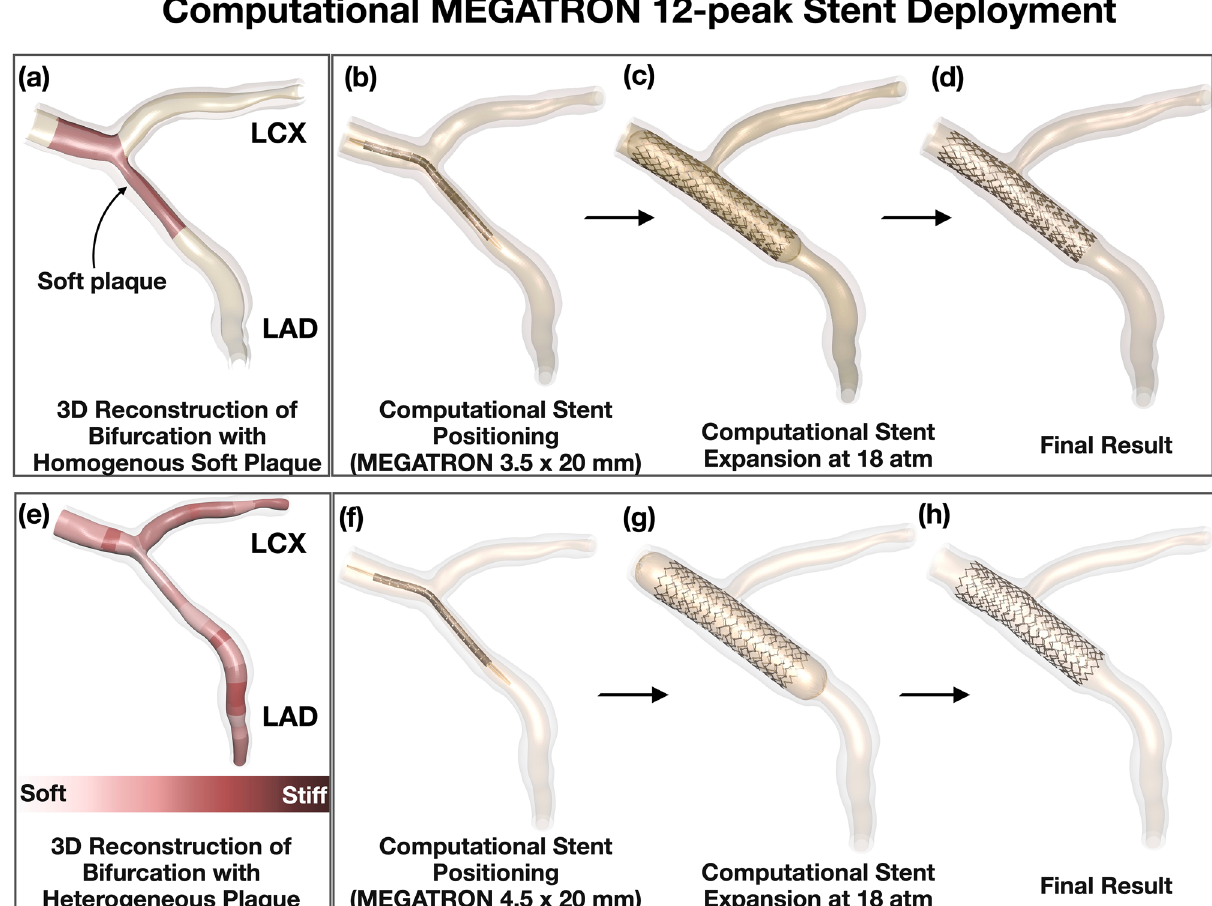
Figure 3. Representative examples of computational MEGATRON 12-peak stent expansion. ( a ) 3D reconstruction of LM bifurcation lumen and wall by angiography and optical coherence tomography and assignment of homogeneous plaque material properties (soft in this example), ( b – d ) Computational MEGATRON stent positioning, expansion, and final result, ( e ) Assignment of heterogeneous (patient-specific) plaque stiffness to the 3D reconstructed LM bifurcation. Note the various zones of patient-specific differential plaque stiffness across the length and circumference of the lumen, ( f – h ) Computational MEGATRON stent positioning, expansion, and final result; LAD: Left anterior descending, LCX: Left circumflex